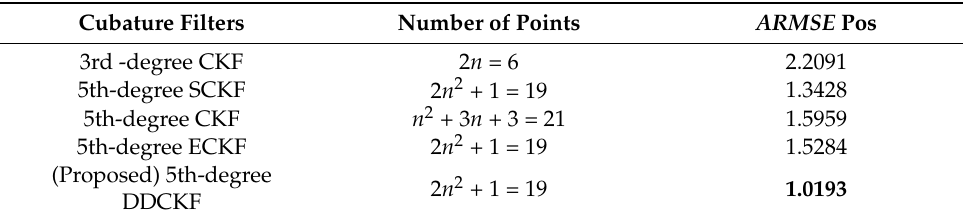
Table 2. Performance indices of the different filters used in Experiment 4.1. Cubature